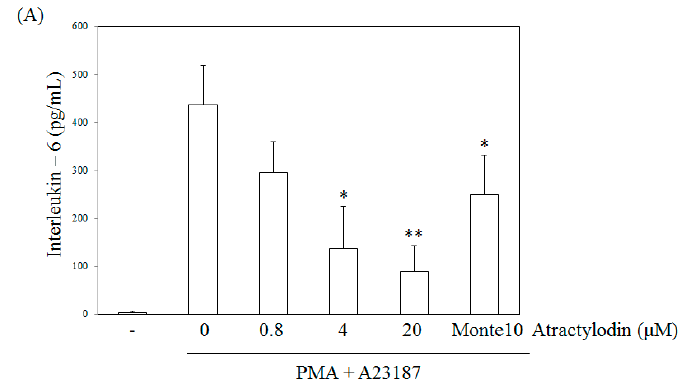
Figure 4. Cont. Figure 4. Cont